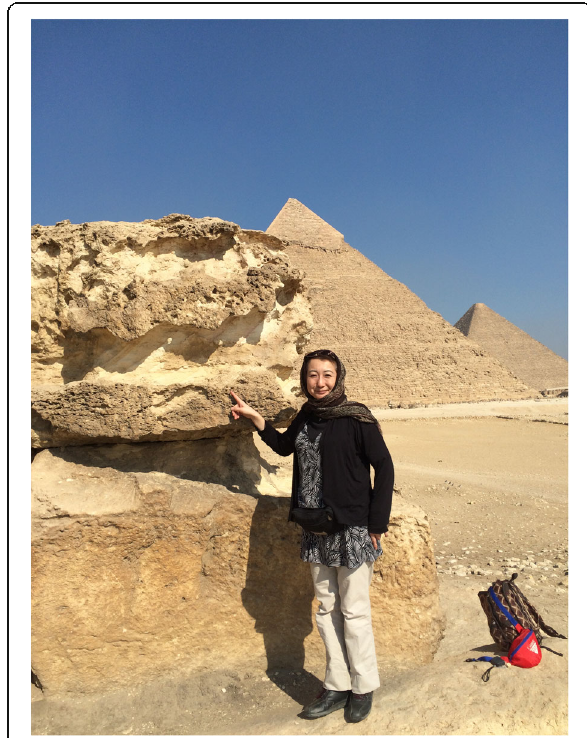
Fig. 2 Example of a honeycomb structure at Giza,